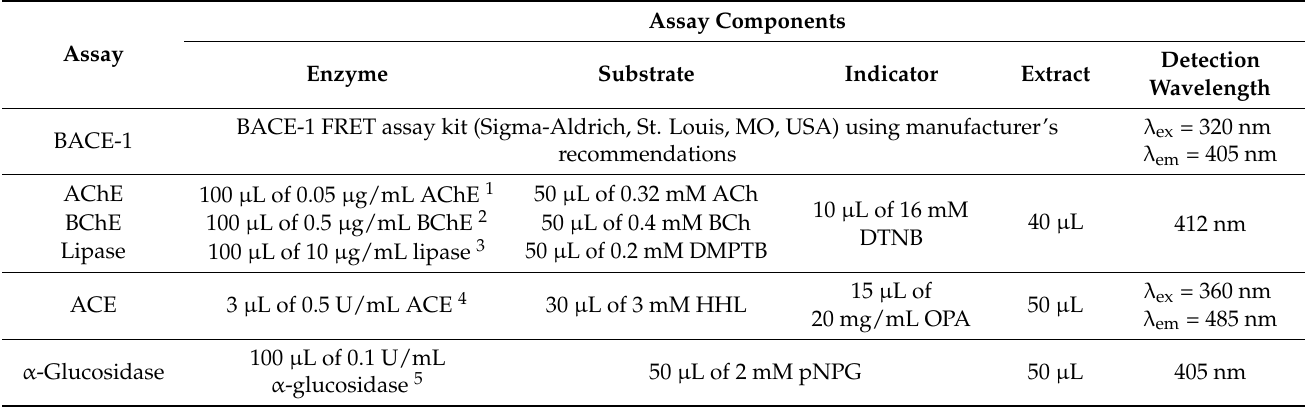
Table 10. The assay components including an enzyme, a substrate, an indicator, a fruit extract and a detection wavelength for enzyme inhibitory assays. Assay Components Assay Enzyme Substrate Indicator Extract